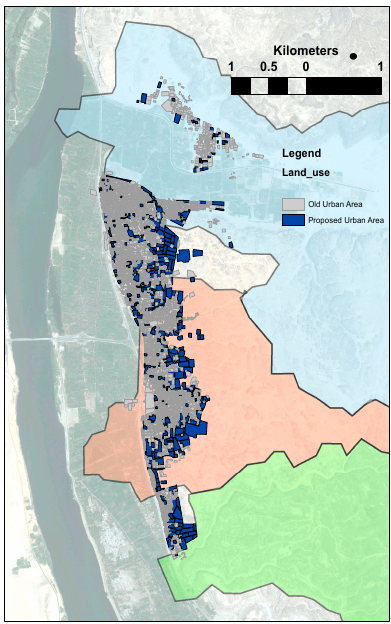
Table 5. Proposed urban area as divided into at risk areas and safe areas. Urban Area